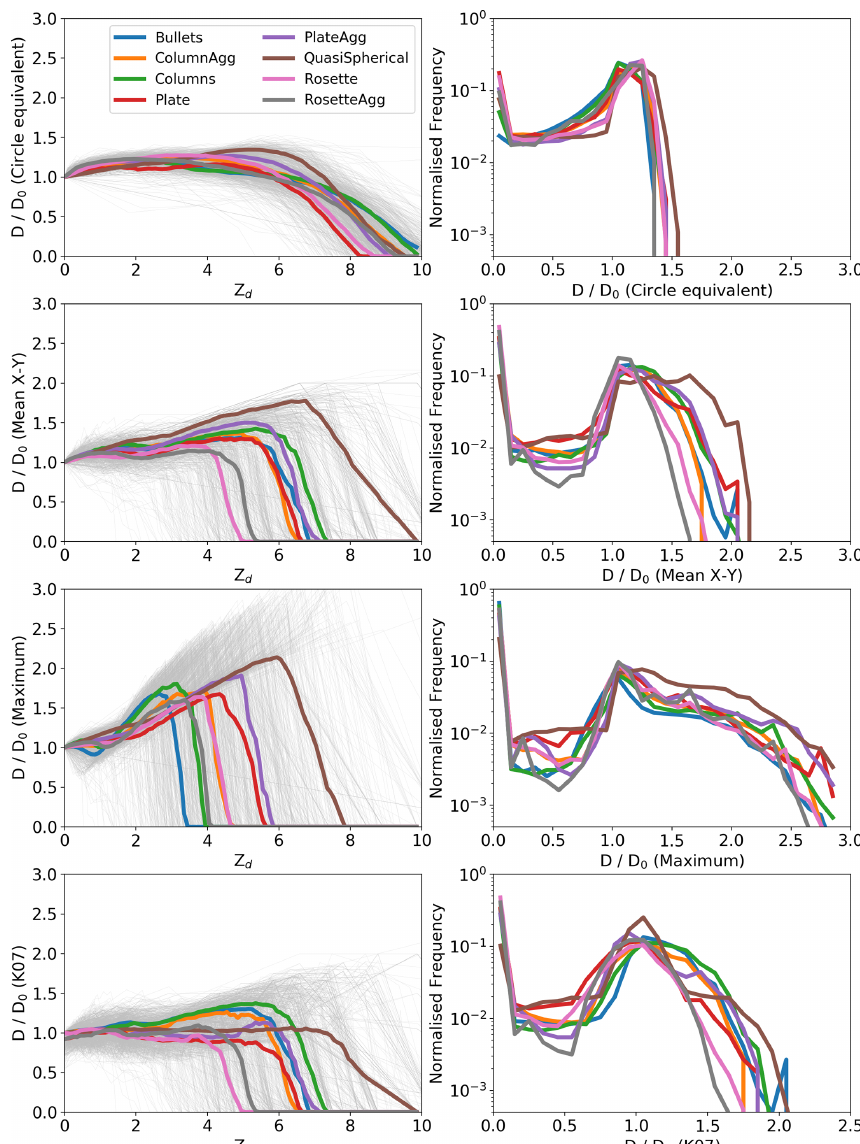
Figure 9. Left panels show the ratio of the measured diameter ( D ) to the true diameter ( D 0 ) vs. Z d for diffraction simulations of 1060 ice crystals. The data for each individual ice crystal are shown as grey lines, while the coloured lines are the median for each habit. Right panels show histograms of D/D 0 for each habit calculated for the Z d range 0 to 10. Top panels show plots using the circle equivalent diameter, while the middle panels use the mean X – Y and maximum diameters. Bottom panels show the diameter corrected using